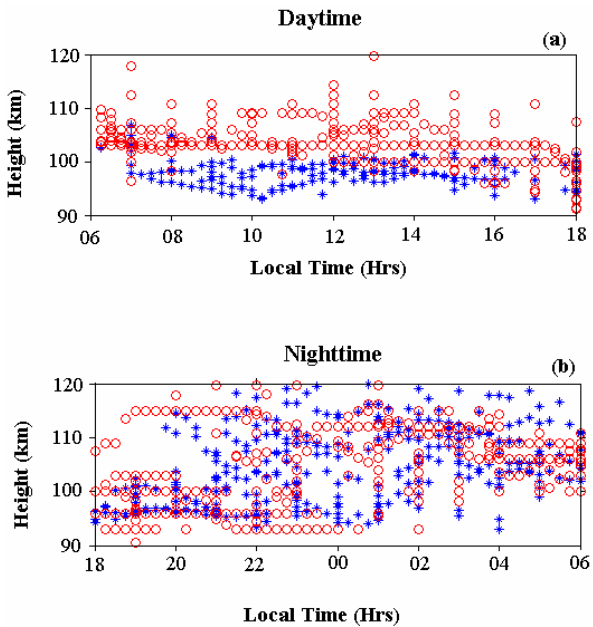
Fig. 3. A comprehensive picture depicting the virtual height of the E s layers, h 0 E s (open circle) and height of the most intense FAI (star) observed during ( a ) daytime on 12 days and ( b ) nighttime on 15 nights.